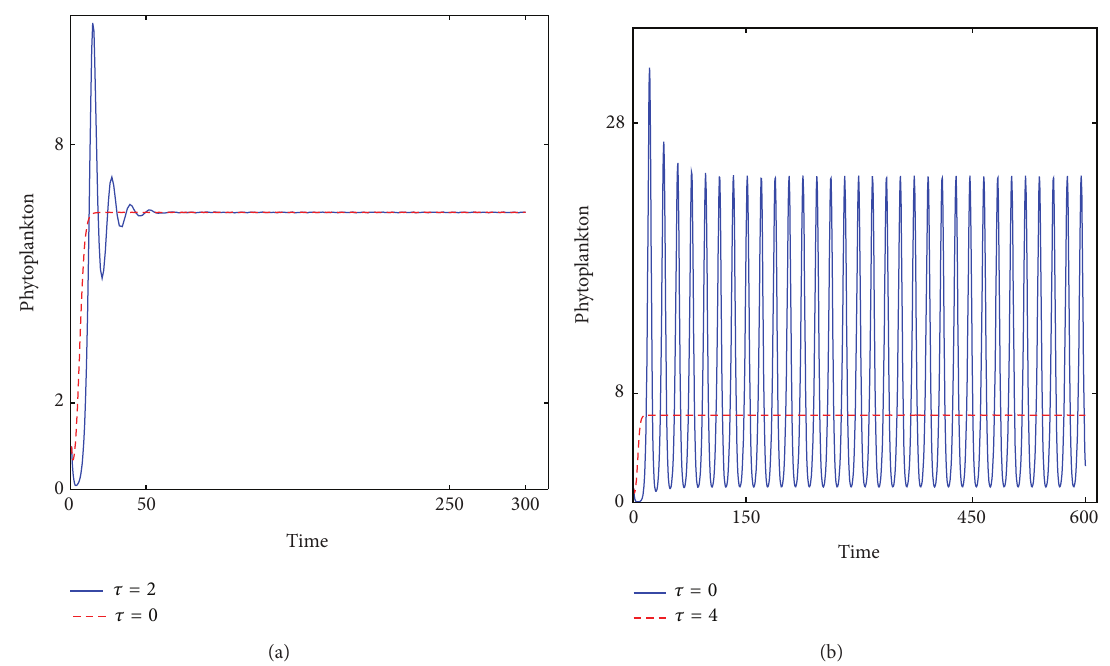
Figure 2: Solution for phytoplankton for 𝑁 0 = 10, ℎ = 1 , and (a) 𝜏 = 2 ; (b) 𝜏 = 4